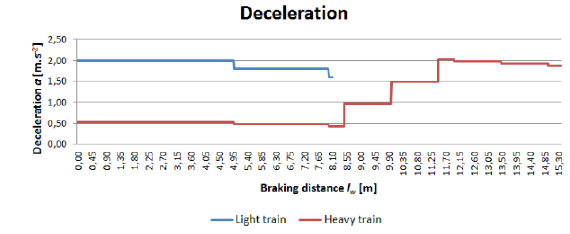
Figure 6. Deceleration rate along the braking dis- tance (Example